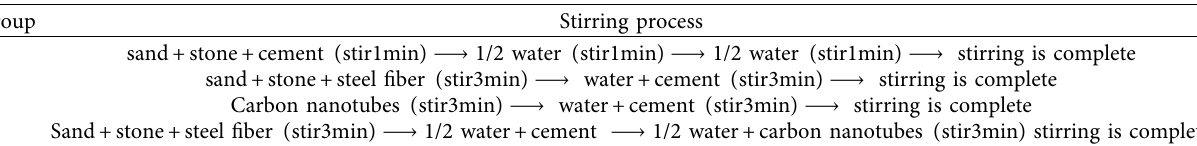
Table 3: Concrete mixing